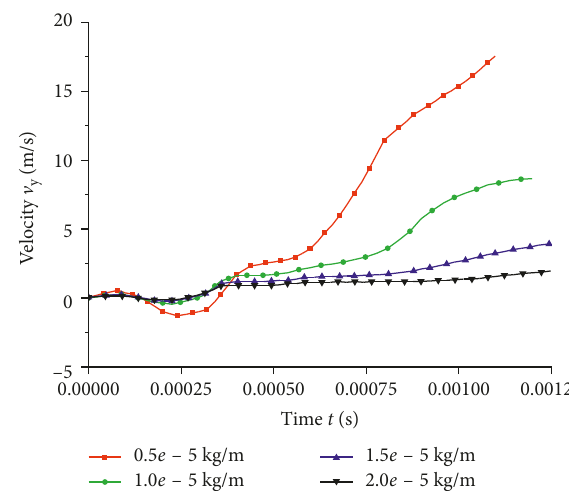
Figure 9: Transverse velocity distribution of end A of fibers with different linear densities.